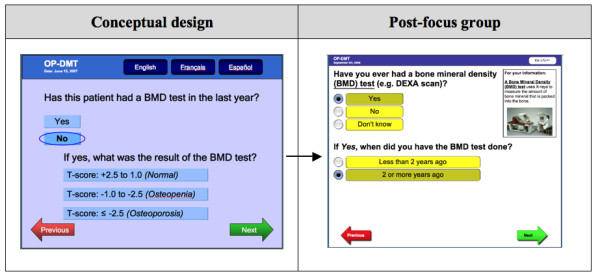
RAQ question about bone mineral density testing.